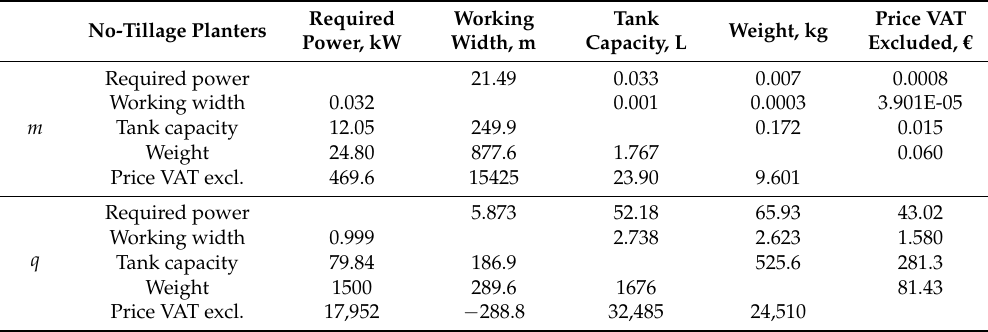
Table 8. Linear coefficient and intercept matrix for functional parameters of no-tillage